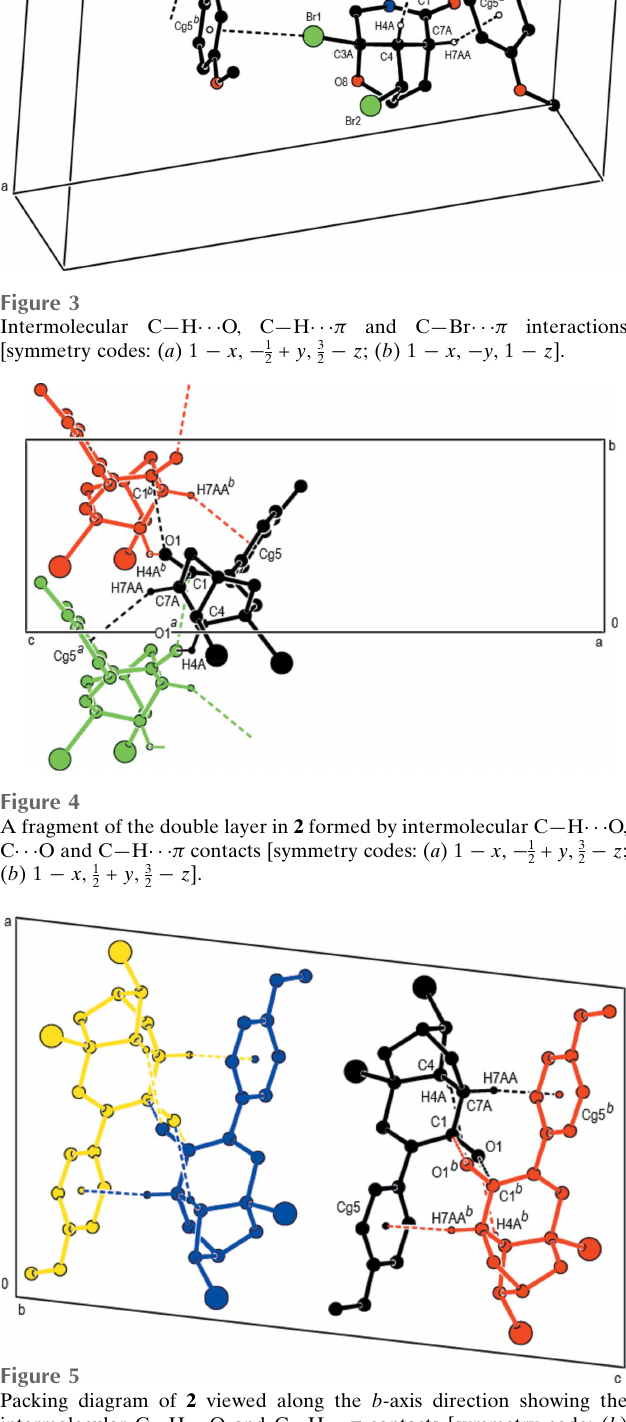
Figure 5 Packing diagram of 2 viewed along the b -axis direction showing the intermolecular C—H (cid:2)(cid:2)(cid:2) O and C—H (cid:2)(cid:2)(cid:2) (cid:2) contacts [symmetry code: ( b ) (cid:3) z ]. 1 (cid:3) x , 1 + y , 3 2 2 534 Mertsalov et al. (cid:5) C 15 H 15 Br 2 NO 3 Acta Cryst. (2021). E 77 , 532–536